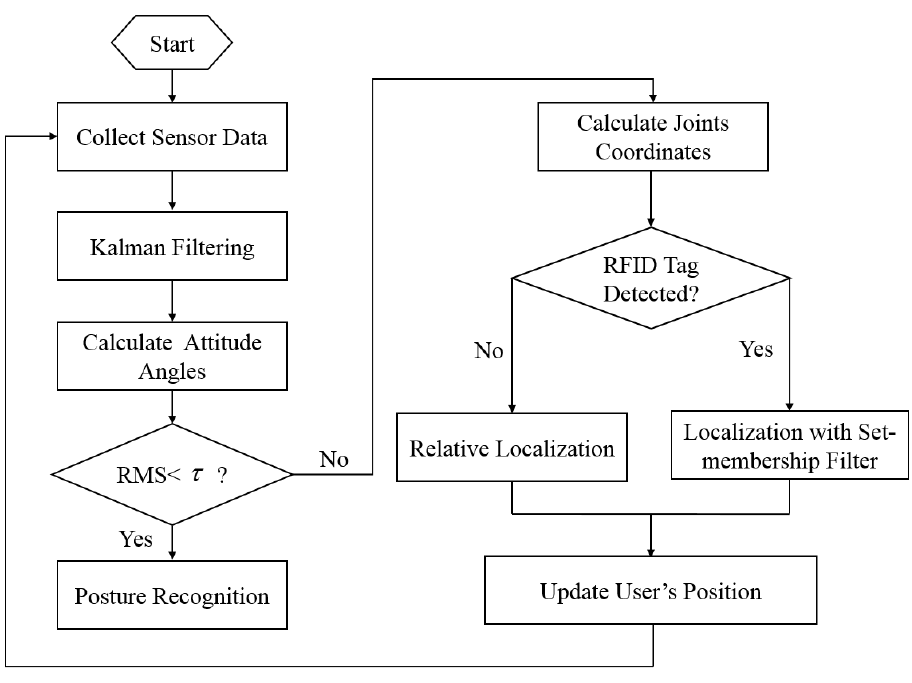
Figure 3. The flow chart of the whole system.